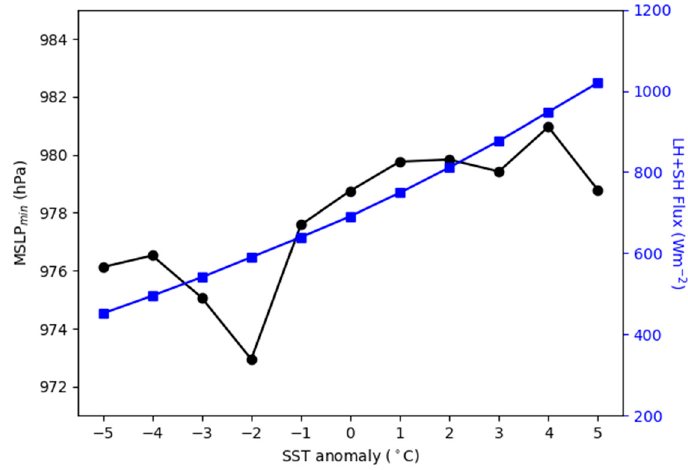
Figure 32. Average latent + sensible heat flux (Wm − 2 ) over the Levantine basin (blue) and the minimum MSLP (black) at the peak of the storm (time of lowest MSLP) for all sensitivity